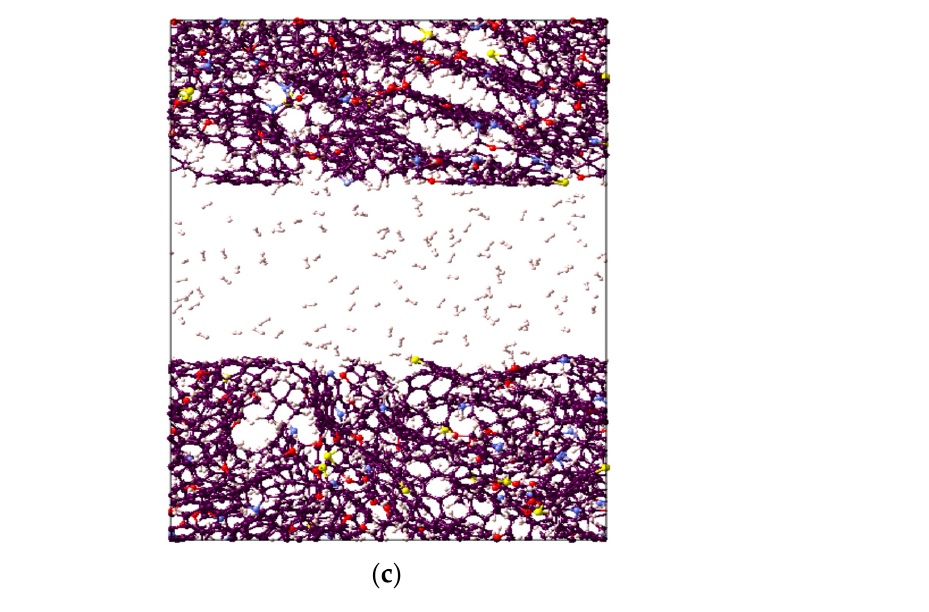
Figure 2. Visual representation of the constructed molecular model for active spots available in II-D overmature-type kerogen for ( a ) CO 2 , ( b ) CH 4 , and ( c ) H 2 absorption within the structure and adsorption on the surfaces.